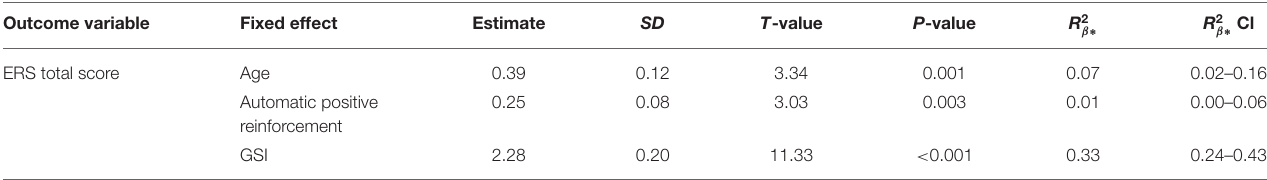
TABLE 4 | Linear mixed effect model predicting the ERS with fixed